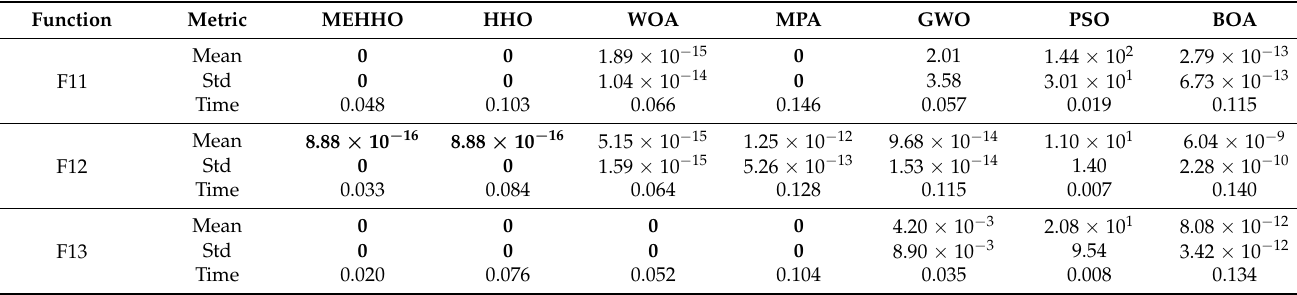
Table 5. Comparison of multimodal functions test